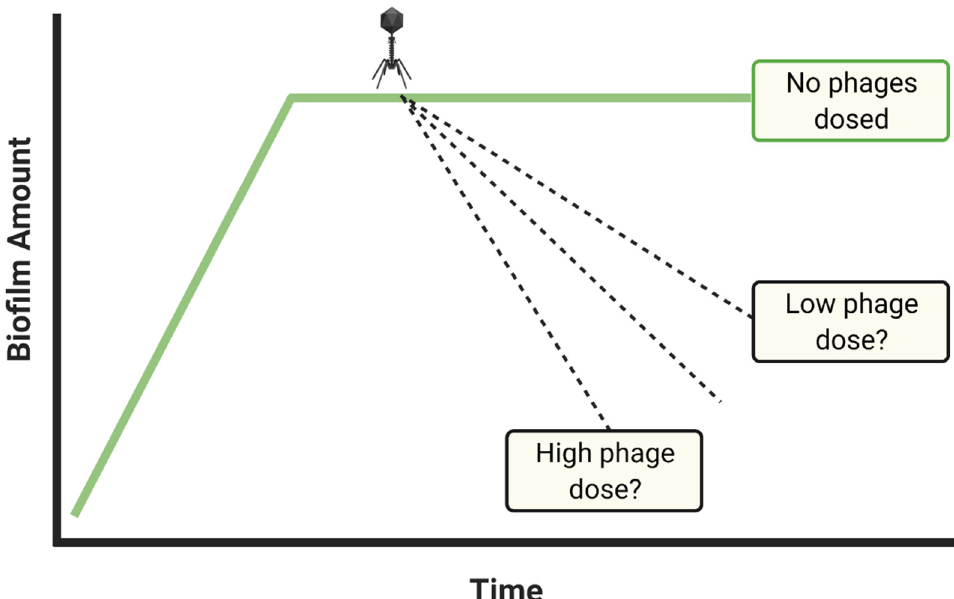
Figure 4. Possible impacts of different phage titers on biofilms. Pharmacologically, it is typical that the application of greater drug amounts will result in greater impacts on target tissues. Dosing with greater numbers of phages, as added in the figure at the phage icon, therefore should generally be attempted toward enhancing anti-biofilm activities, particularly when desired anti-biofilm activity is not otherwise achieved. This should especially be rather than employing as maximum doses phage MOIs of approximately 1 or lower. The middle dashed line, unlabeled, is meant to describe the results of some in-between phage dose. Created with